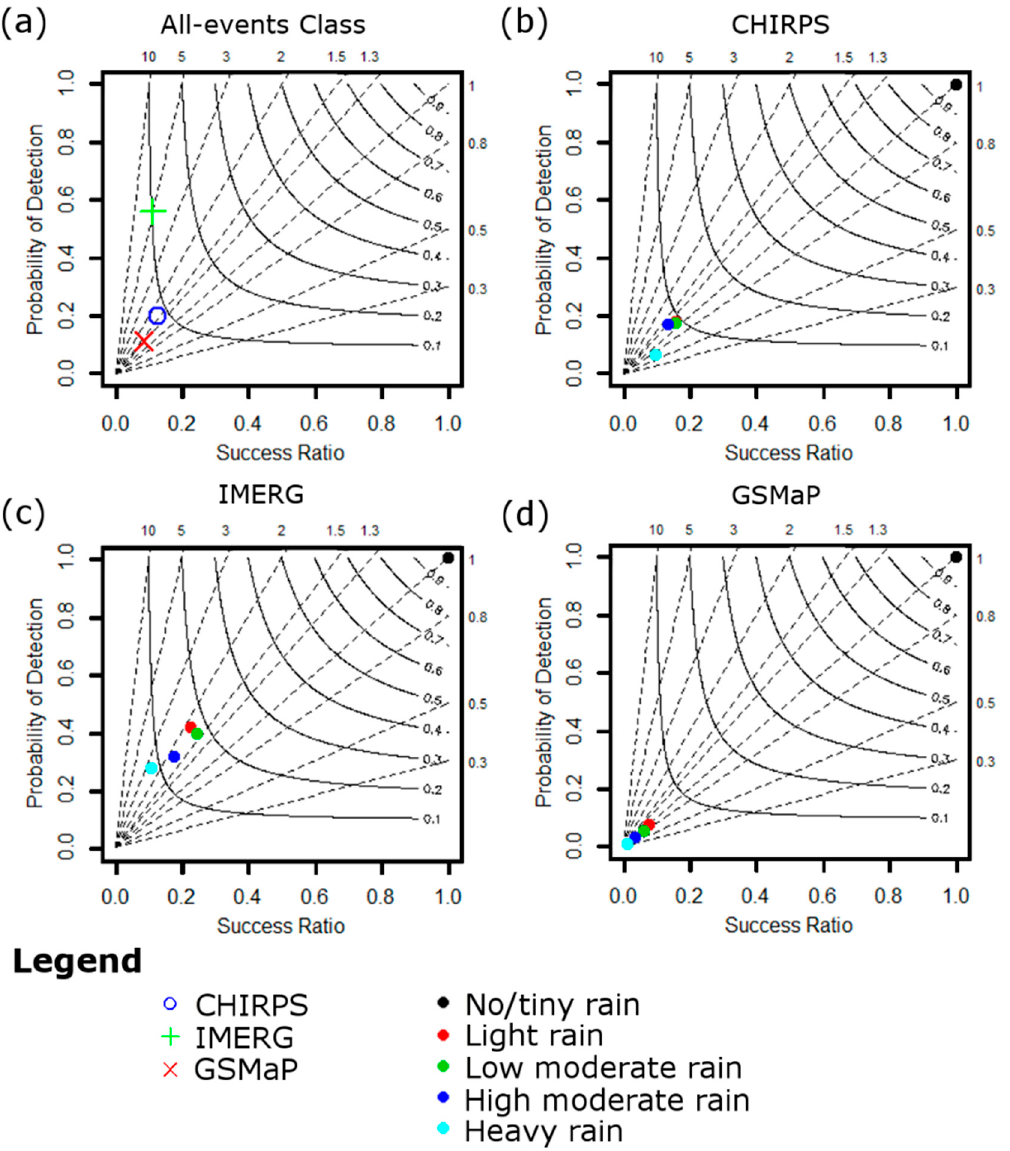
Figure 10. The performance chart of CHIRPS, IMERG, and GSMaP in detecting ( a ) all-events class, and ( b ) CHIRPS, ( c ) IMERG, and ( d ) GSMaP in detecting rainfall events having different intensity ranges.